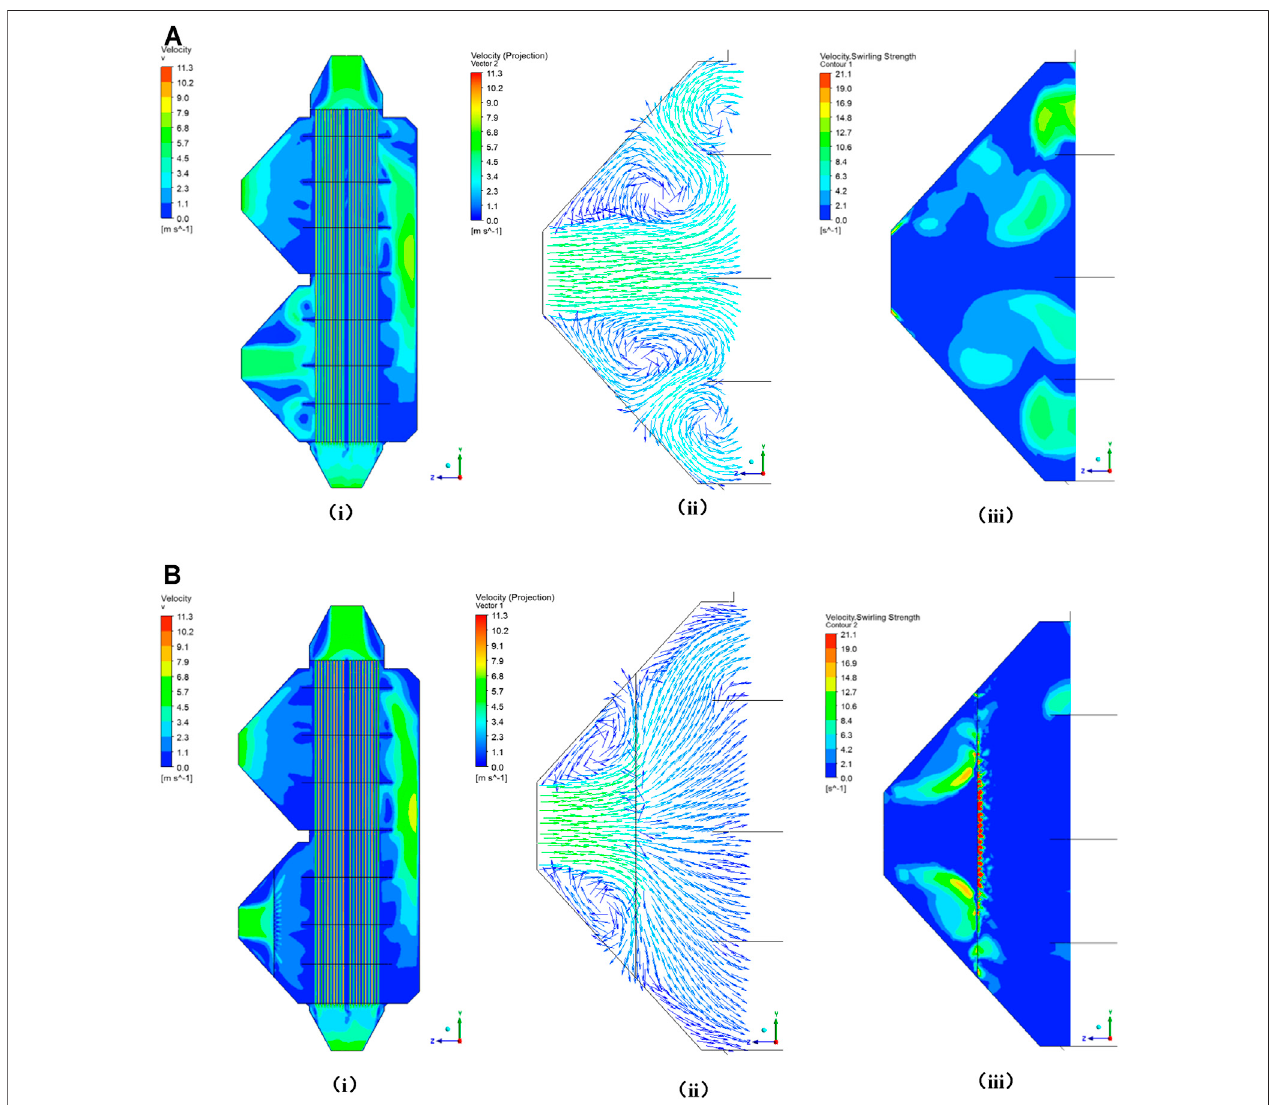
FIGURE 2 | Flow fi eld distribution: (A) without grid and (B) with grid. (i) Velocity cloud, (ii) Velocity vector of the cold fl uid inlet, (iii) Vortex intensity of the cold fl uid inlet.